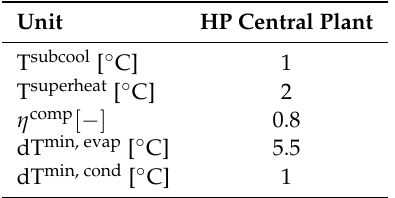
Table A13. Parameters for central plant